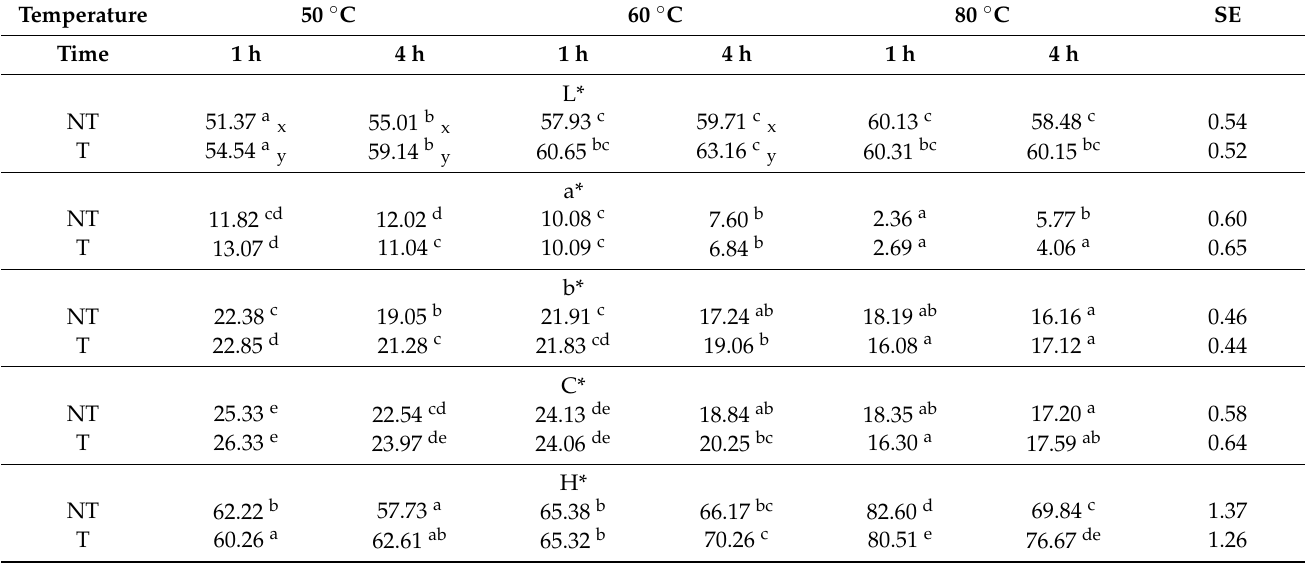
Table 2. Lightness (L*), redness (a*), yellowness (b*), chroma (C*) and hue (H*) values measured on bovine Semitendinosus muscle samples previously tumbled (T) or not (NT, used as control) and then sous-vide cooked at 50 ◦ C, 60 ◦ C or 80 ◦ C for 1 h or 4 h. The data correspond to mean values calculated from 9 individual measurements performed on three different ST muscles. Different superscript letters (a–e) refer to the significant differences between all treatment procedures, and the subscript letters x and y, when indicated, refer to significant differences between control (NT) and tumbled (T) muscle